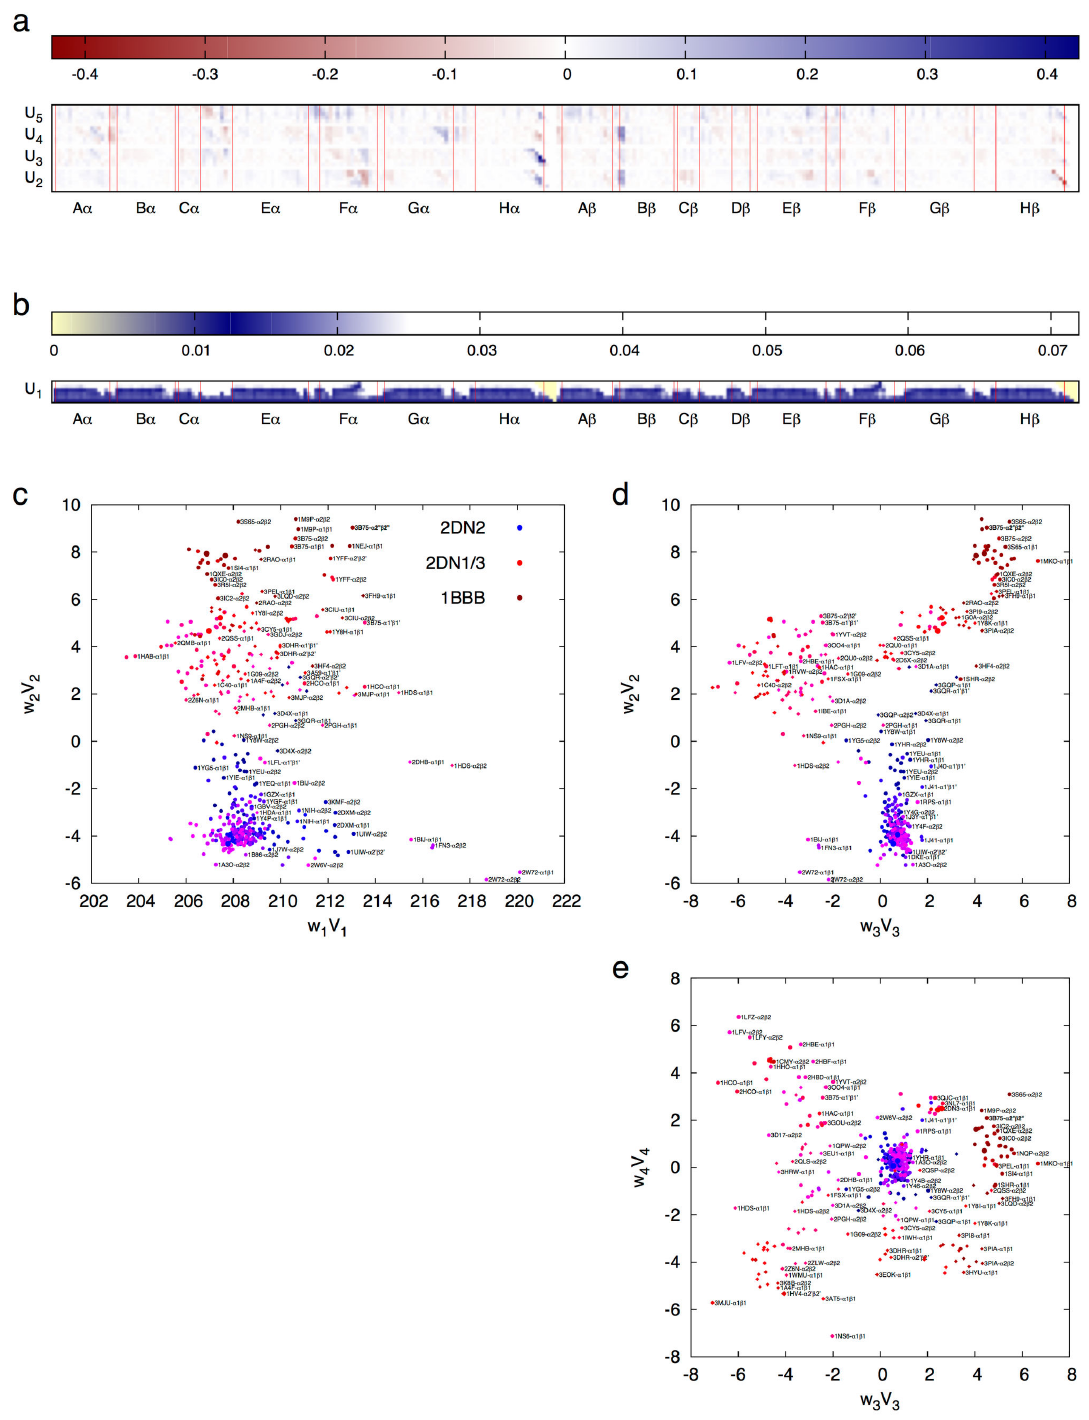
Figure 6. SVD analysis of HIMs. SVD analysis is applied to HIMs of 560 αβ dimers in the structural collection. a . Left singular vectors U - U . b . Left singular vector U . This can be considered as the average of all 560 HIMs. c - e . Scatter plots of the first four 2 5 1 dimensions of SVD. For example, each value of w V indicates how much composition of U 2 2 labeled by small typeface as much as possible if the labeling is not interfering with other graphing, and are only visible on a digital copy. The continuous color scheme is identical to that in Figure 2. Structures of human and non-human Hb are indicated by solid dots and diamonds, respectively. doi: 10.1371/journal.pone.0077141.g006 PLOS ONE |